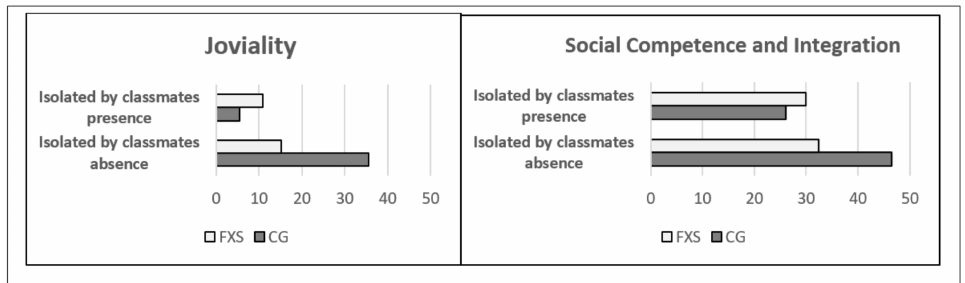
Figure 3. Interaction of “Isolated by classmates” with Group on Social Competence and Integration, and Joviality. FXS = Fragile X Syndrome. CG = control